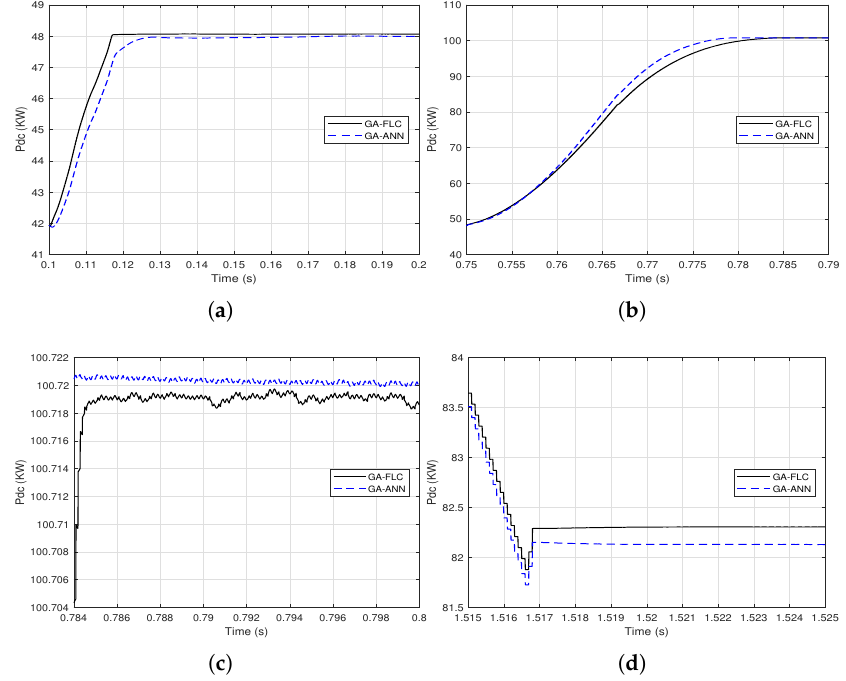
Figure 15. Proximate views of the output DC power of the PV array when using the GA-FLC and the GA-ANN based MPPT methods for step variations of G and T c : ( a ) from 0.1 to 0.2 s; ( b ) from 0.75 to 0.79 s; ( c ) from 0.784 to 0.8 s; ( d ) from 1.515 to 1.525 s.